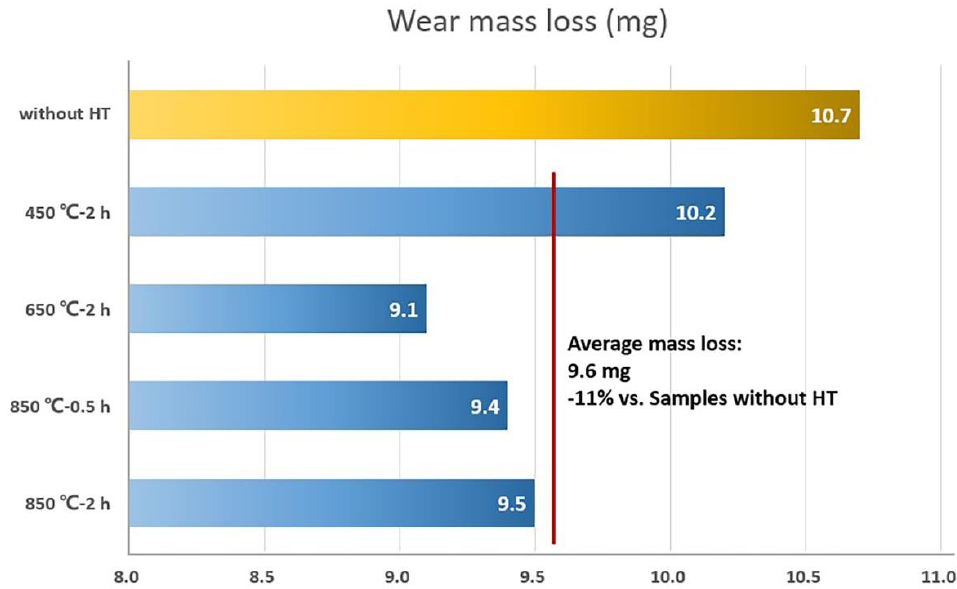
Figure 12. Wear mass loss results for the coatings during the friction and wear test.